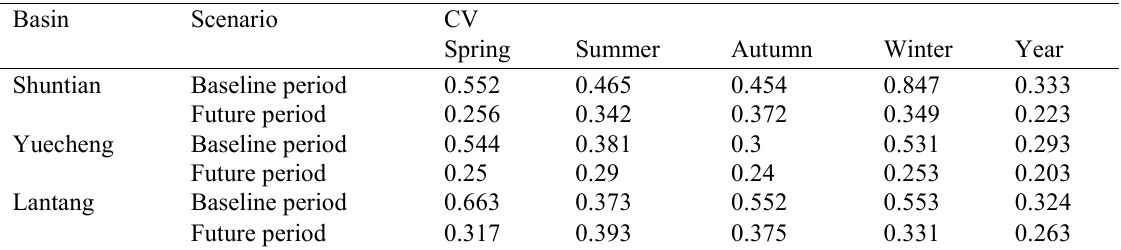
Table 4 The CV of runoff during the baseline period and future